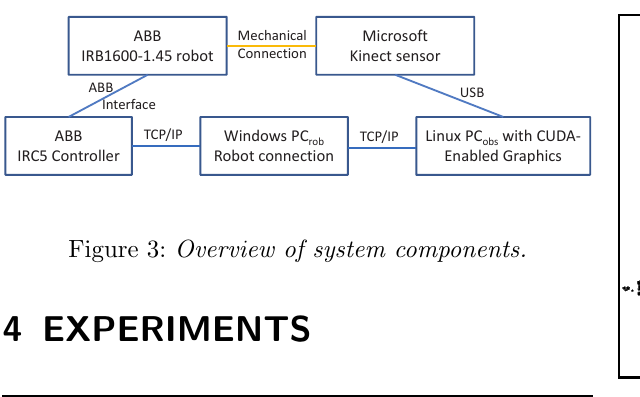
Figure 5: Illustration of centre points in Octree. 100mm sidelengths were used for the robot and 1mm sidelengths for the environment.